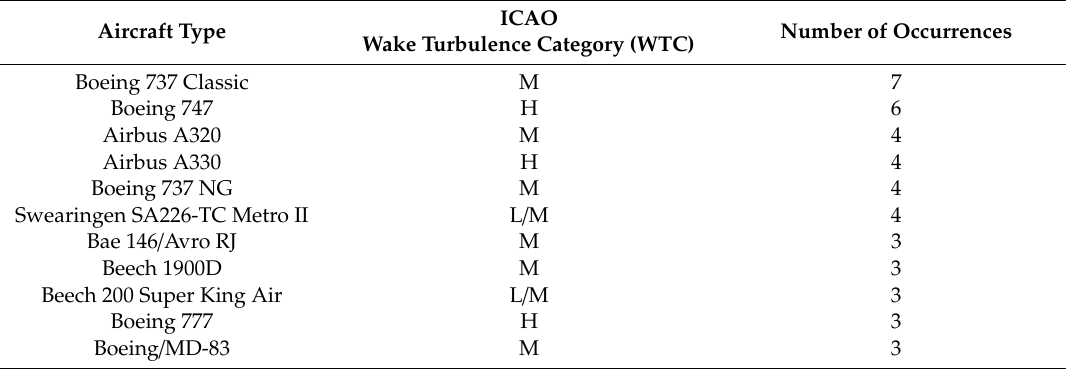
Table A1. Breakdown of events by aircraft